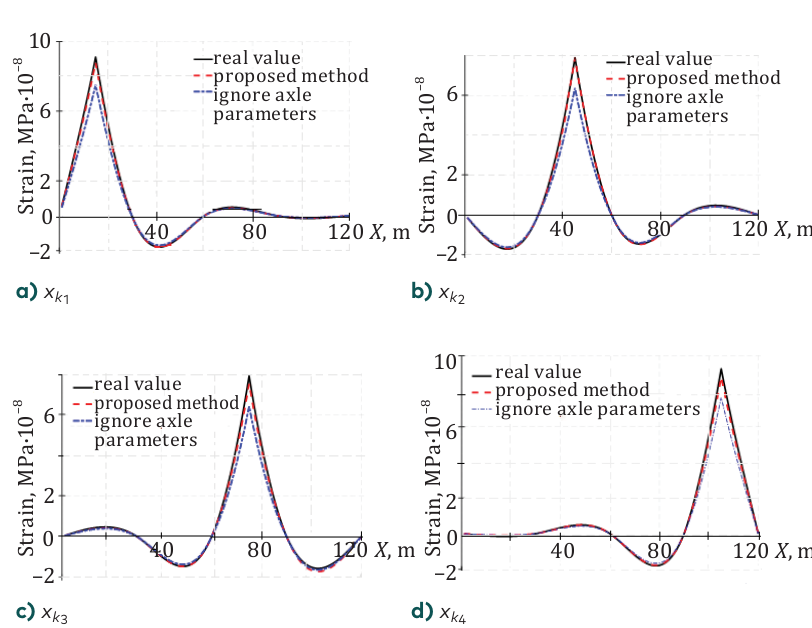
Figure 10. The error of the calculated correction factor